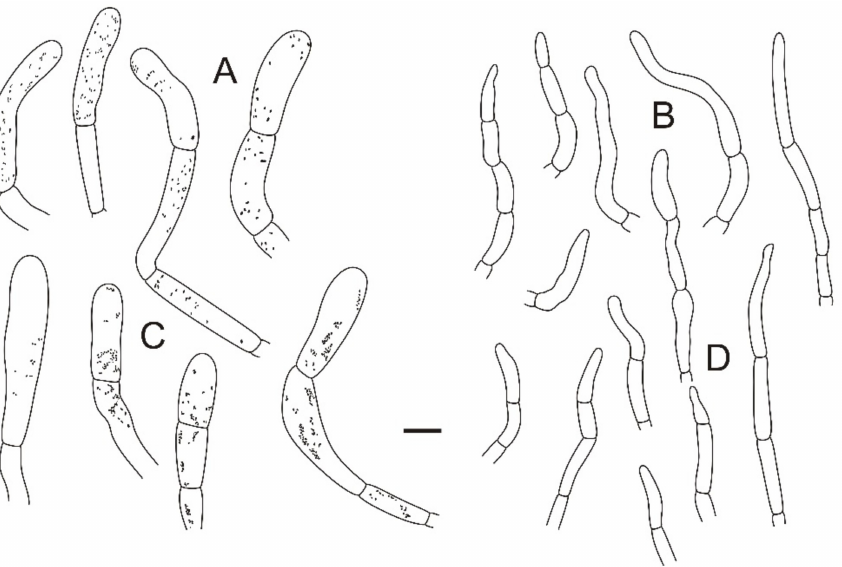
Figure 25. Microscopic features of Russula yanshanensis (BJTC C561). ( A ) Pileocystidia near the pileus margin. ( B ) Hyphal terminations near the pileus margin. ( C ) Pileocystidia near the pileus center. ( D ) Hyphal terminations near the pileus center. Scale bar: 10 µ